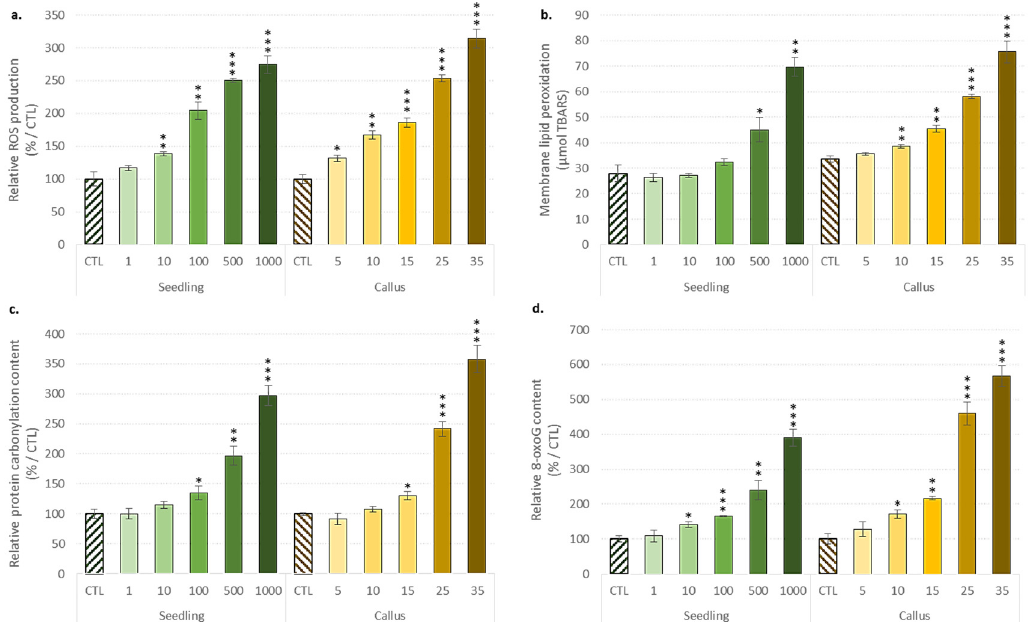
Figure 2. Evaluation of the oxidative stress induced by the ZnONP application on the seedlings and the stem-derived callus of L. usitatissimum . ( a ) The reactive oxygen species (ROS) formation (relative fluorescence unit); ( b ) the membrane lipid peroxidation ( µ mol thiobarbituric acid-reactive substances; TBARS); ( c ) the protein carbonylation formation (A 405 / 10 µ g protein); ( d ) the 8-oxo guanine (8-oxo-G) formation (A 405 / 10 µ g protein). Values are means ± SD of three independent experiments; * p < 0.05, ** p < 0.01, *** p < 0.001.